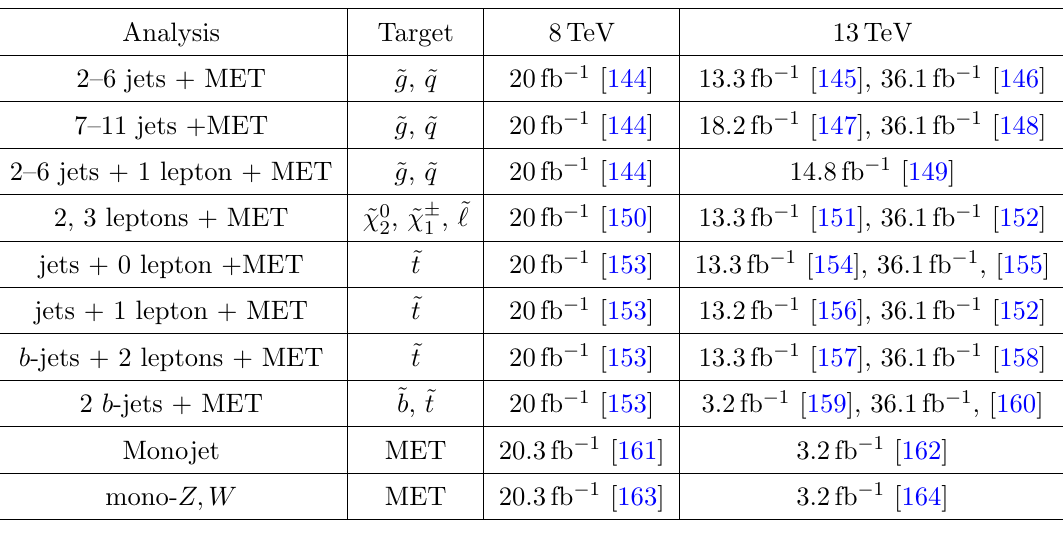
Table 8 . List of ATLAS searches implemented in this